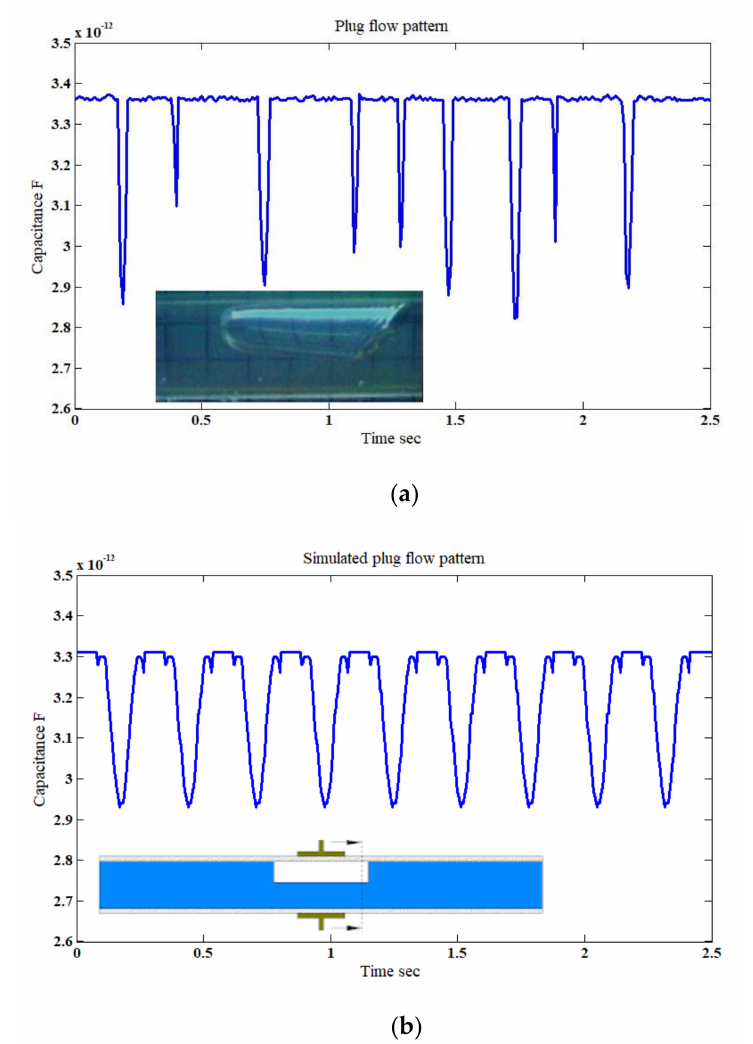
Figure 9. The time-dependent fluctuation of the capacitance value for the plug flow pattern: ( a ) experimental [32], and ( b ) simulation (for the superficial gas–liquid phase velocities 0.212 m / s and 0.26 m / s, respectively; inclination angle β = 30 ◦